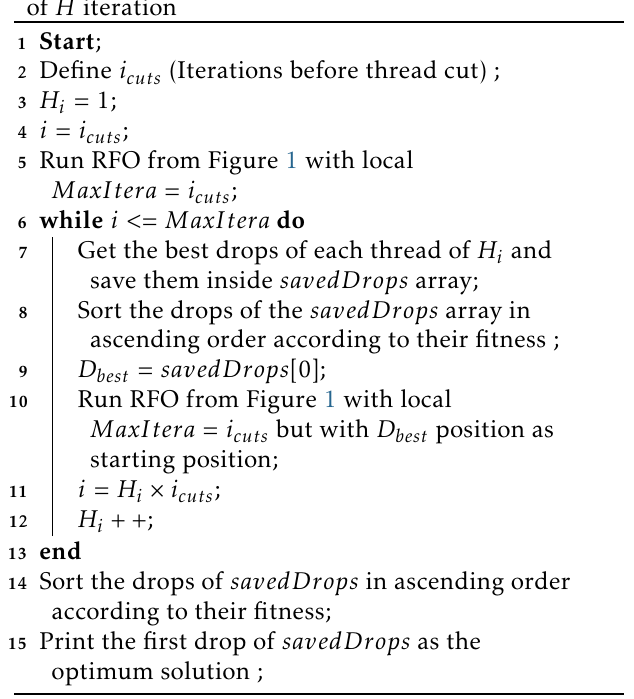
Algorithm 1: Pseudocode to obtain the best drop of H